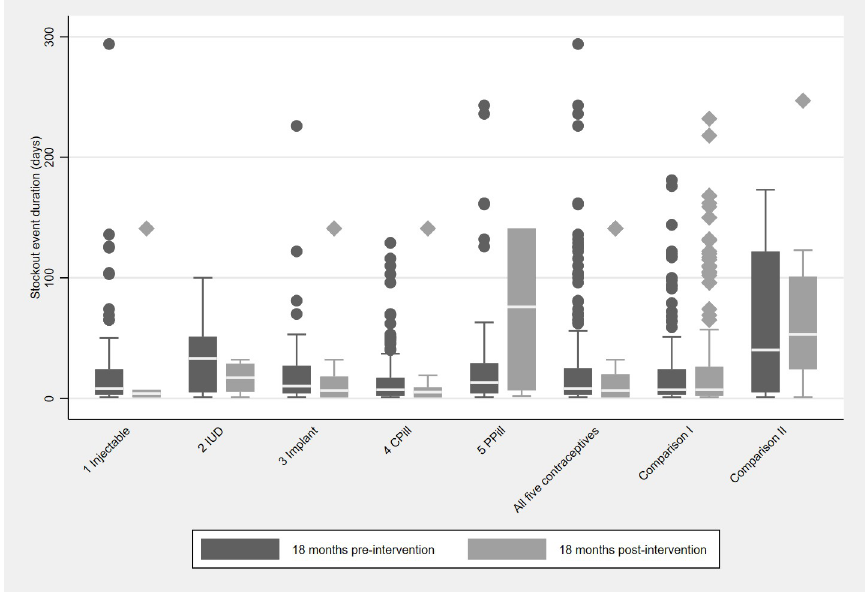
Fig 2. Duration of stockout events per contraceptive product pre- and post-intervention. 103 Senegalese health facilities; Distribution non-adjusted for sampling weights; Contraceptive product (n before, n after): injectable (92, 5), IUD (intrauterine device; 17, 8), Implant (57, 14), CPill (combined pill; 120, 13), PPill (progesterone-only pill; 49, 4), Comparison I (amoxicillin syrup; 121, 216), Comparison II (artemisinin-based combination therapy for babies; 11, 16); Intervention: Informed Push Model; Outliers > 300 d were removed (n = 3 before and n = 4 after the intervention); Very long ( > 100 days) stockout durations are probably the result from missing data for several months after a